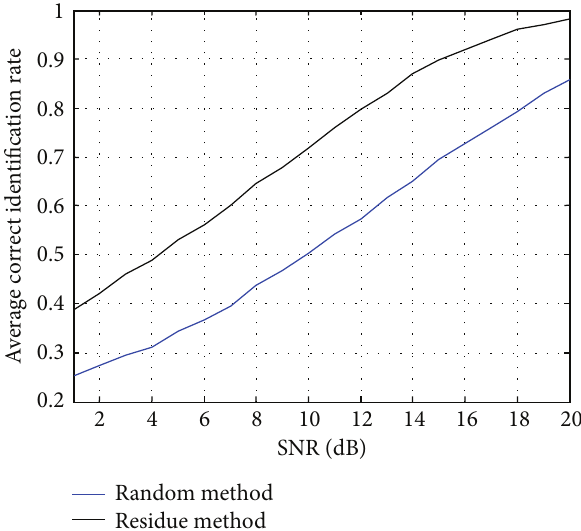
Figure 8: Average correct recognition rate changes with the signal- to-noise ratio by different frequency selection methods for 6 classes of